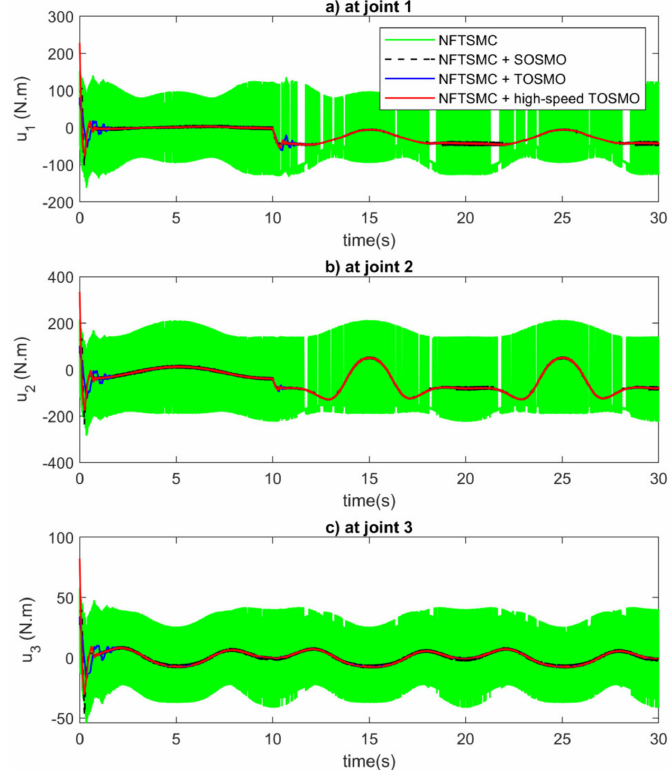
Figure 7. Comparison of control input torque among controllers at ( a ) joint 1, ( b ) joint 2 and ( c ) joint 3.